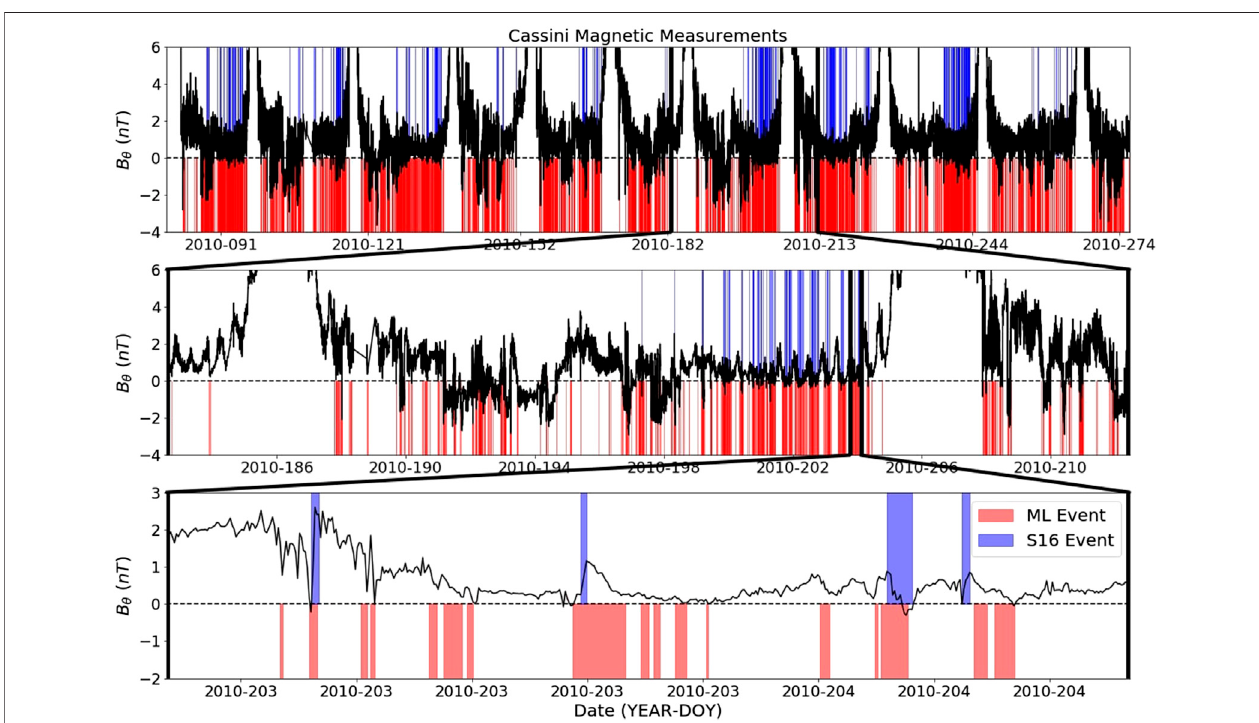
FIGURE6| Outputofreconnectionsignaturesidenti fi edbyafeedforwardneuralnetwork(redareas)acrosshalfof2010comparedtoidenti fi cationsfromtheSmith catalog (blue areas) for the same period. These areas are overplot onto the B θ component of the magnetic fi eld, where reconnection signatures are easiest identi fi ed by eye. Each successive plot examines zoomed in windows to observe fi ner structure in magnetic fi eld measurements and identi fi cations.